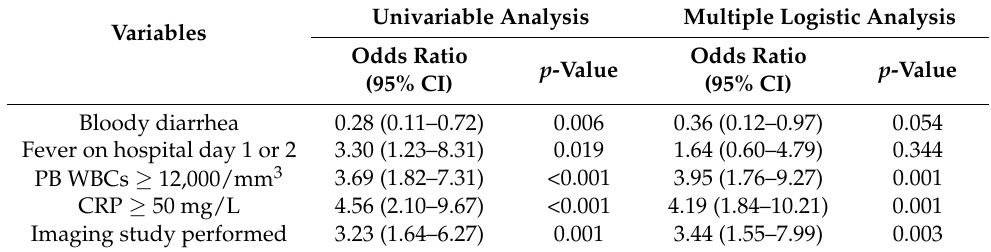
Table 4. Factors associated with early antibiotic therapy.